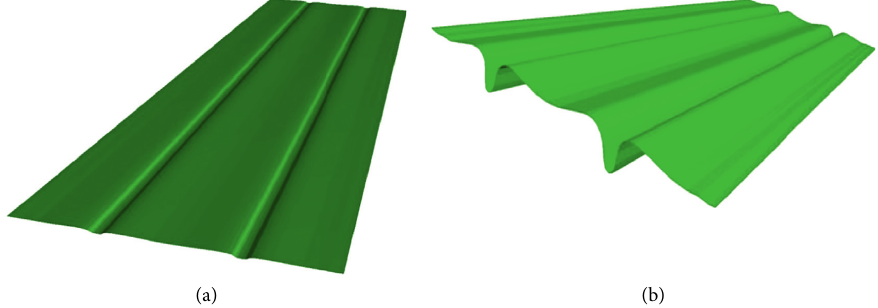
Figure 7: Generated deformed pavement surface. (a) Unscaled. (b) 10x vertically scaled.